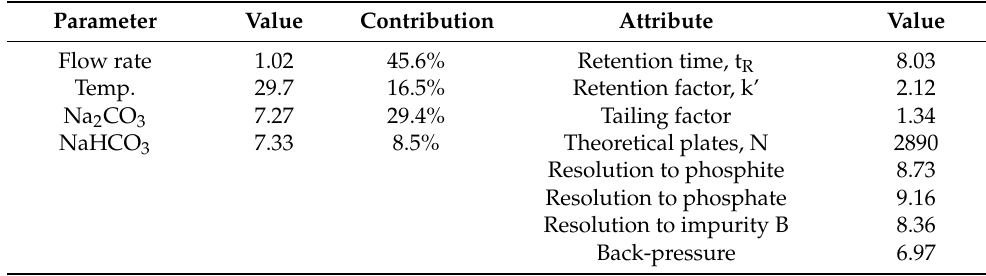
Table 5. Calculated robust setpoint method conditions, including factor contributions and predicted quality control attributes.